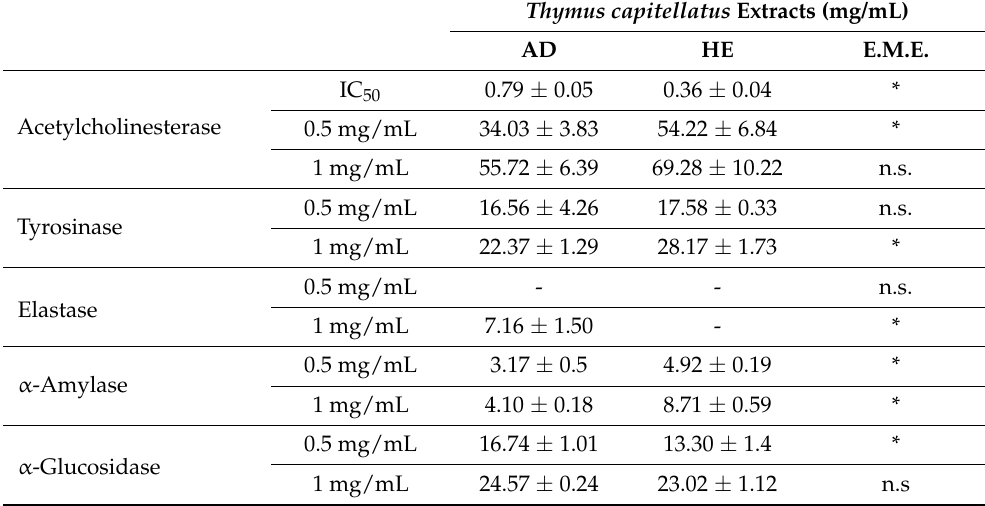
Table 3. Assessment of T. capitellatus extract’s inhibition of acetylcholinesterase, tyrosinase, elastase, α -amylase and α -glucosidase. Thymus capitellatus Extracts